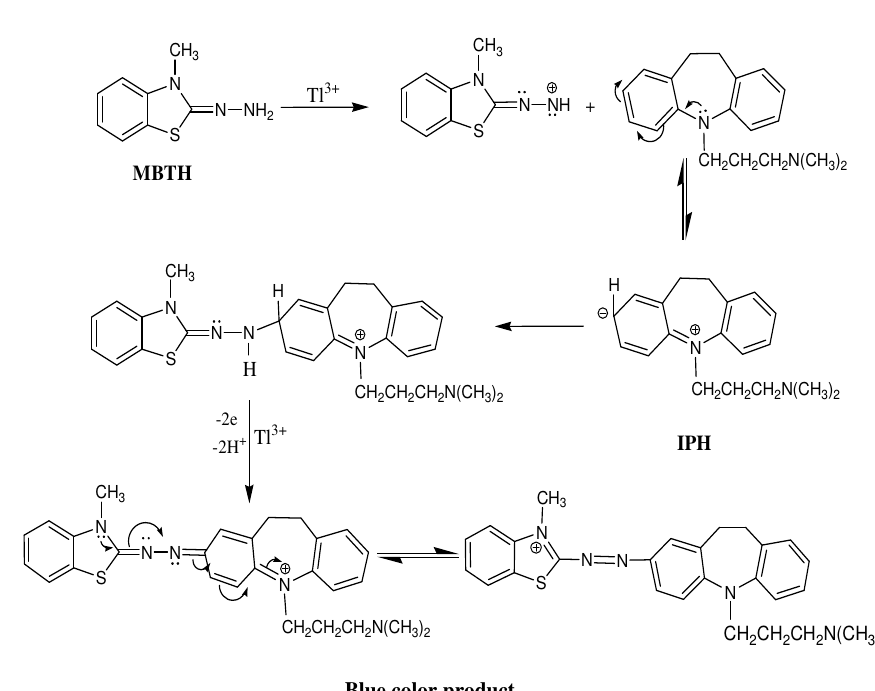
Scheme 1. Reaction pathway for the formation of colored product by MBTH and IPH Performance of the proposed method and statistical comparison with reported